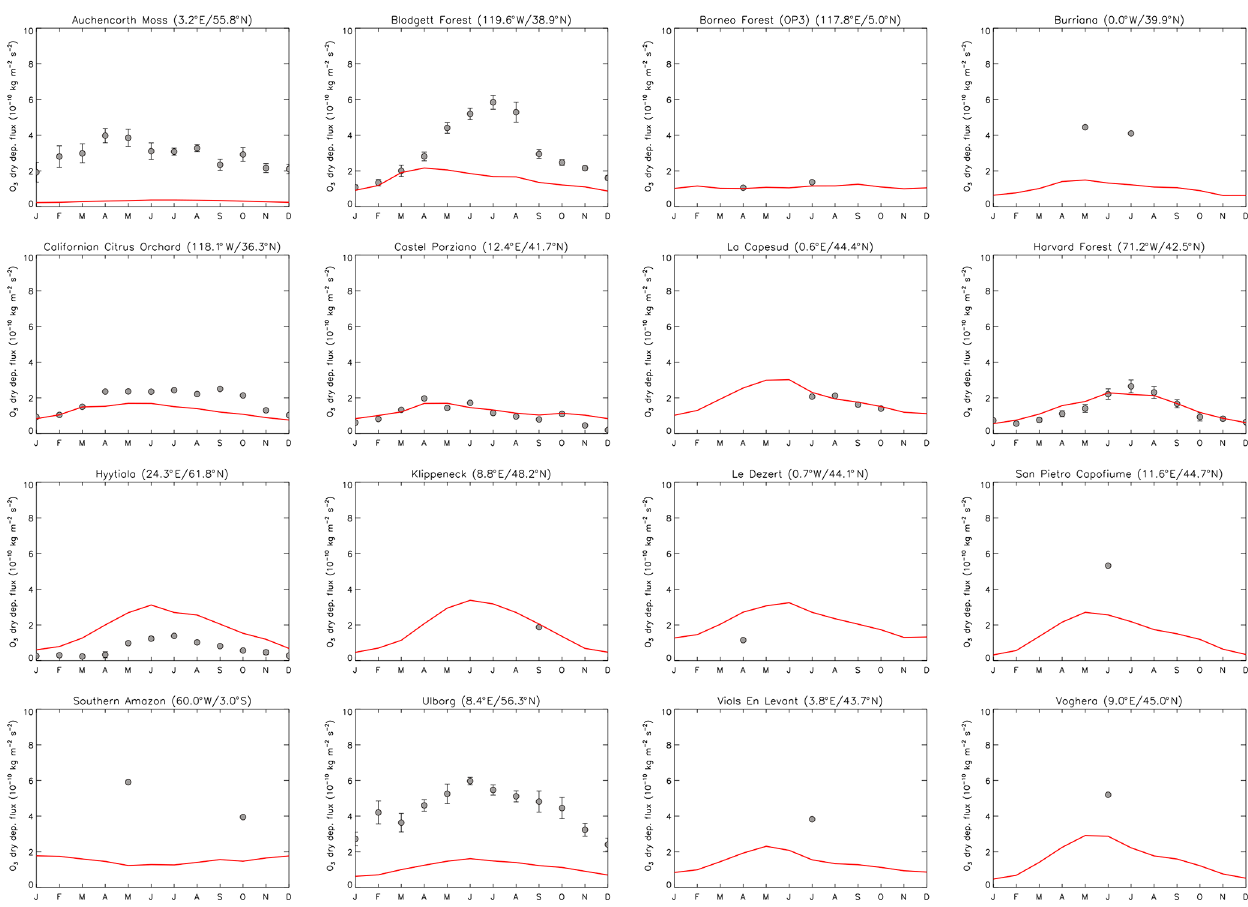
Figure 9. Comparison of observed and modelled monthly mean ozone dry deposition fluxes. Grey circles indicate monthly mean ozone deposition fluxes at measurement sites (see Table 3 for site details); error bars denote standard errors. Solid red lines represent modelled multi- annual average monthly mean O 3 deposition fluxes extracted from UKCA StratTrop ND in UKESM1 at the site locations by interpolation of the nearest grid boxes (averaged over all surface tiles in these grid boxes). Ozone dry deposition fluxes are given in 10 − 10 kgm − 2 s − 1 , and measurement data are from Hardacre et al. (2015) and references